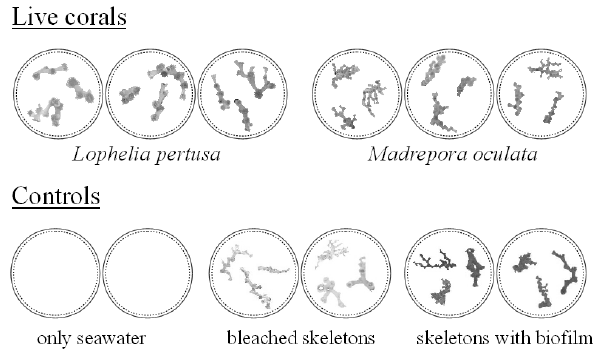
Fig. 1. Experimental